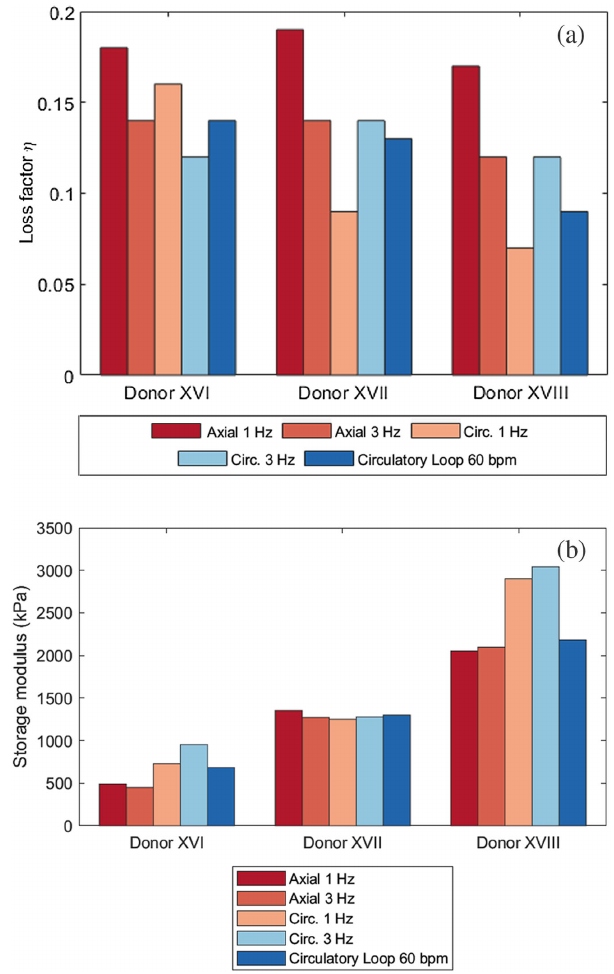
FIG. 10. Comparison of viscoelastic parameters obtained for uniaxial harmonic tests on circumferential and axial strips and in the MCL at around 60 bpm pulse rate. Axial strips: uniaxial harmonic tests at 1 and 3 Hz at physiological cyclic strain according to donor age (donor XVI ¼ 5 %; XVII ¼ 5 %; XVIII ¼ 2 . 5 % in engineering strain) under physiological initial pre-stretch (donor XVI ¼ 1 . 33 ; XVII ¼ 1 . 40 ; XVIII ¼ 1 . 23 corresponding to about 70 kPa of nominal stress). Circumferential (circ.) strips: uniaxial harmonic tests at 1 and 3 Hz at physiological cyclic strain according to donor ’ s age (donor XVI ¼ 5 %; XVII ¼ 5 %; XVIII ¼ 1 . 5 % in engineering strain) under physiological initial pre-stretch (donor XVI ¼ 1 . 59 ; XVII ¼ 2 . 07 ; XVIII ¼ 1 . 39 corresponding to about 70 kPa of nominal stress): (a) loss factor; (b) storage modulus. maroon box, axial 1 Hz; dark brown box, axial 3 Hz; light brown box, circ. 1 Hz; light blue box, circ. 3 Hz; dark blue box, circulatory loop at 60